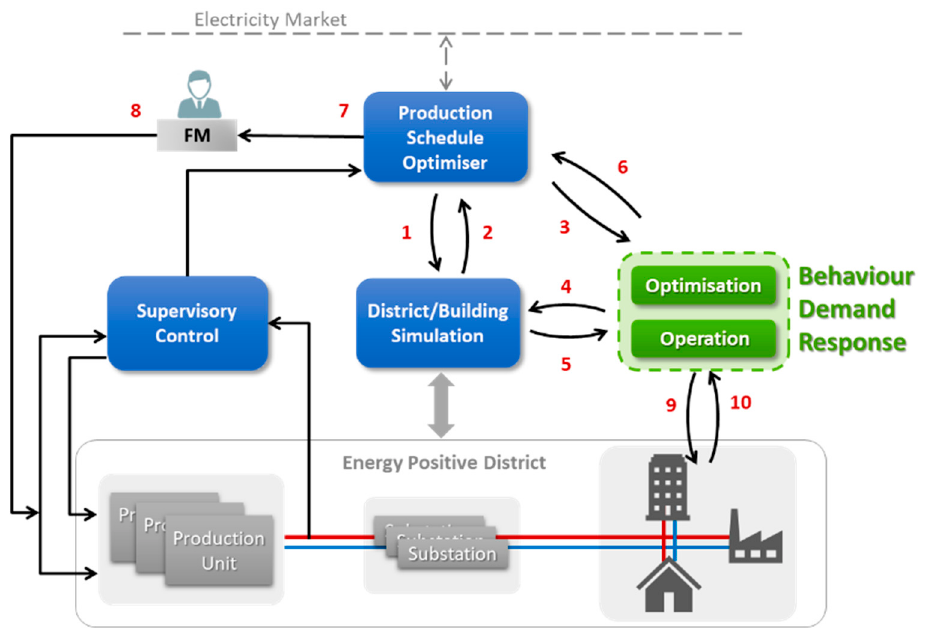
Figure 2. A system architecture integration all four key components of model-driven energy system